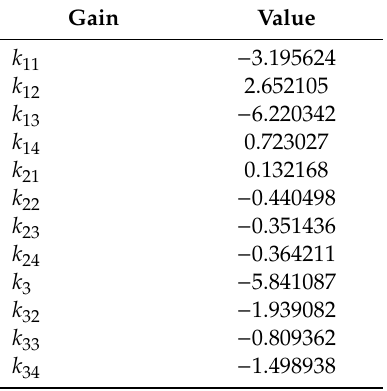
Table A5. Gains of the observer for ω r > 0.